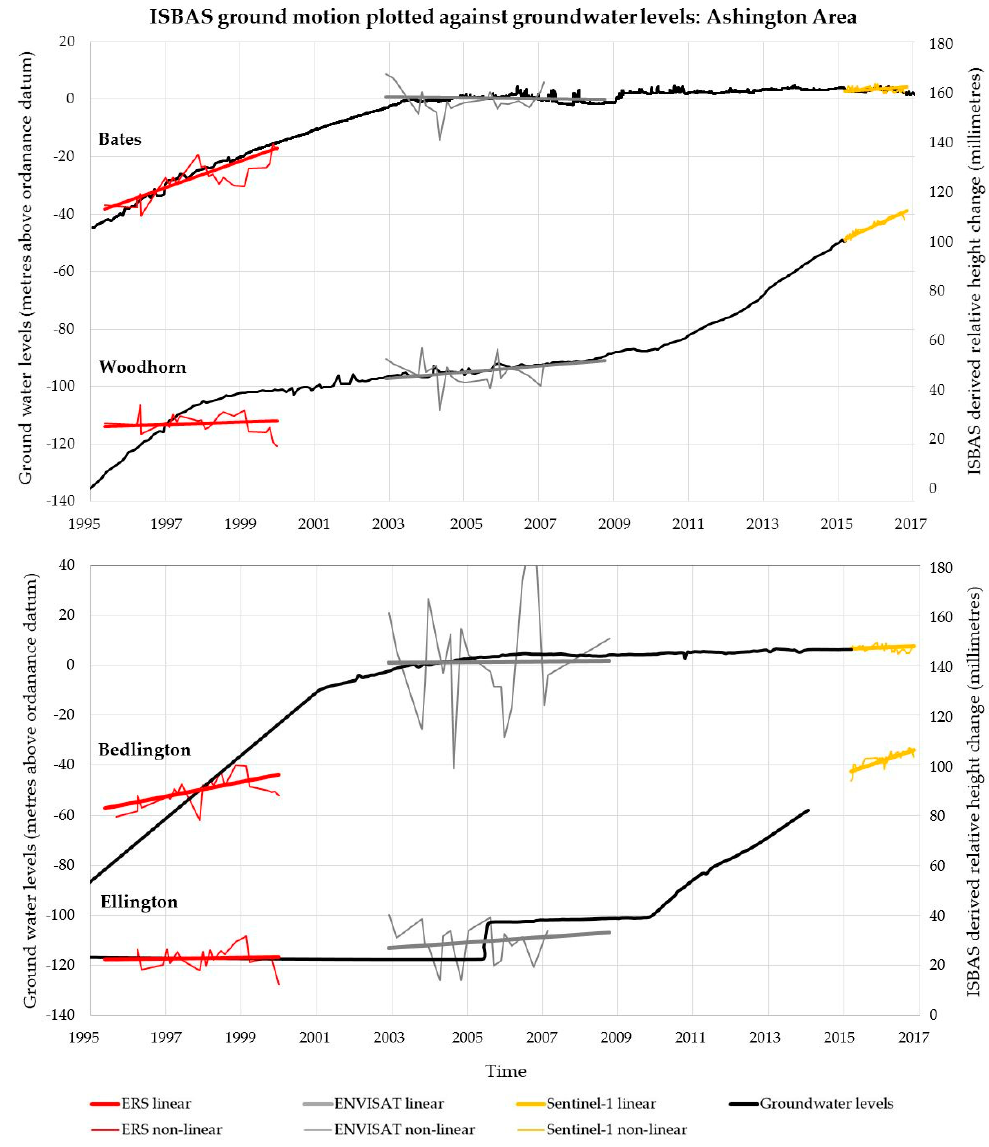
Figure 13. Groundwater levels plotted against neighbouring ISBAS time-series and linear velocities (derived separately) at Bates, Woodhorn, Bedlington and Ellington, the locations of which are marked on Figure